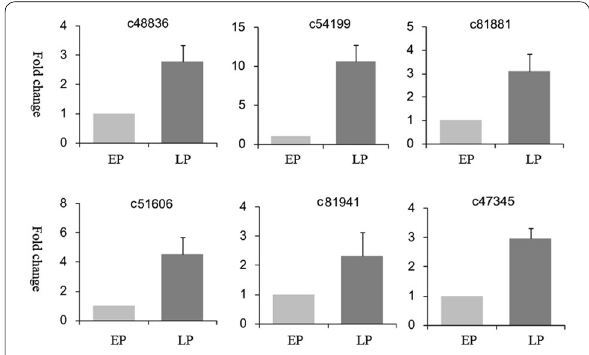
Fig. 6 Quantitative PCR validations of six genes that were differen- tially expressed between the early-stage protocorms (EP) and the late-stage protocorms